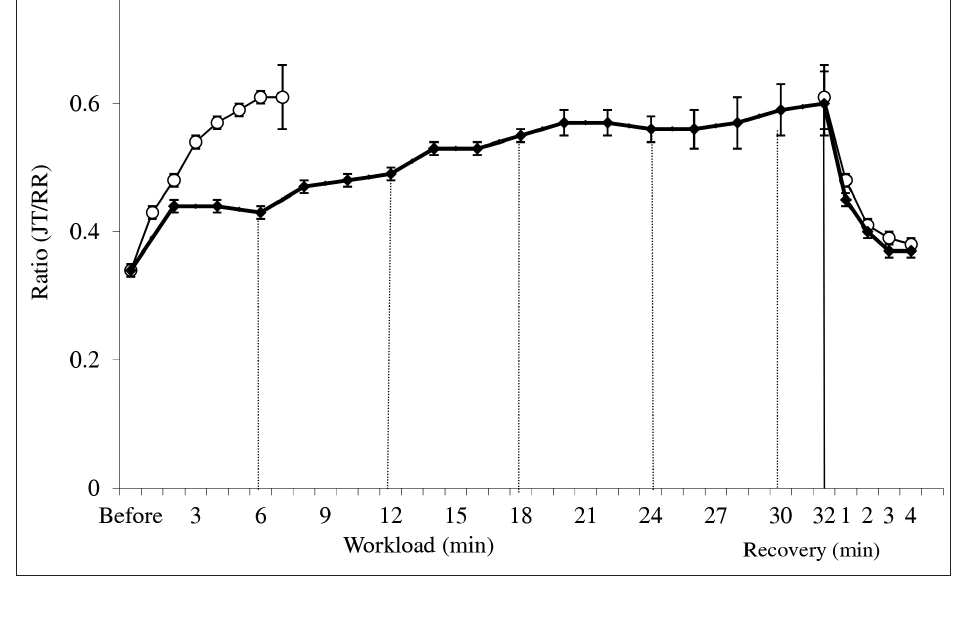
Table 2. Values of ECG indices registered du- ring the graded exercise stress while two different protocols were